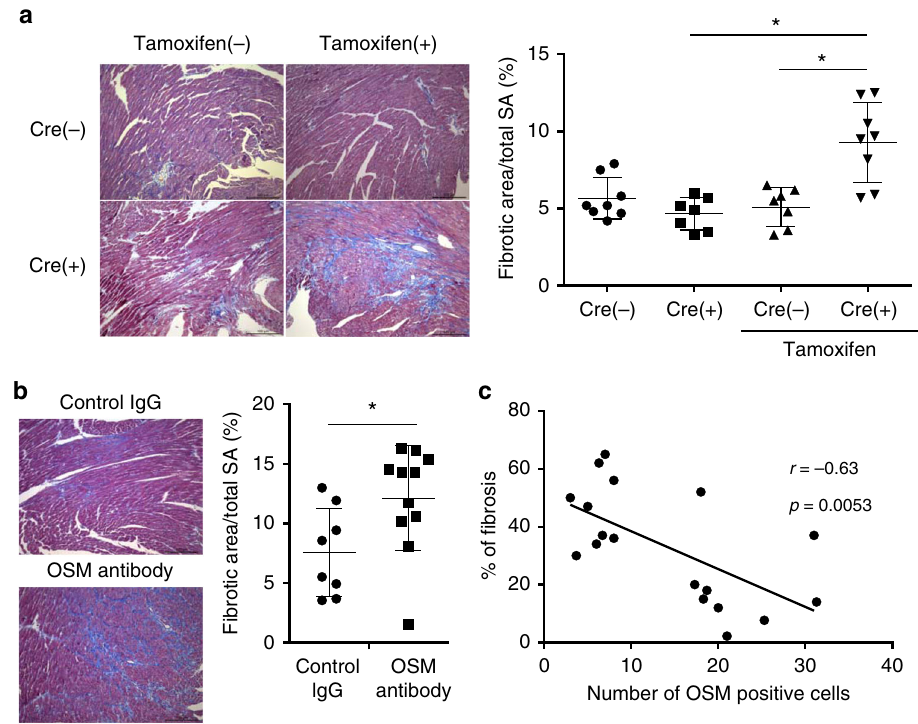
Fig. 6 OSM suppresses cardiac fi brosis in vivo. Masson ’ s trichrome staining was performed using cardiac tissue of fi broblast-speci fi c Osmr knockout mice ( OSMR fl ox/ fl ox ; Col1a1-creERT , Cre( + )) 14 days after TAC operation. Cre negative littermates (Cre( − )) or tamoxifen untreated littermates were used as controls. Fibrotic area was calculated compared to the total surface area (SA) (right). The Kruskal – Wallis test was used for the statistical analysis. (Cre( − ), tamoxifen( − ): n = 8, Cre( + ), tamoxifen( − ): n = 7, Cre( − ), tamoxifen( + ): n = 7, Cre( + ), tamoxifen( + ): n = 8). Scale bar = 100 μ m. b The effect of neutralizing antibody to OSM on cardiac fi brosis was examined. Neutralizing antibody to OSM (100 μ g) or control IgG (100 μ g) was injected intravenously 3 days after TAC operation. Masson ’ s trichrome staining was performed using cardiac tissue 14 days after TAC operation. Fibrotic area was calculated compared to the total surface area (SA). The Mann – Whitney U test was used to compare differences between the control IgG ( n = 8) group and OSM antibody group ( n = 11). Data show the mean and the standard deviation (error bar). Scale bar = 100 μ m. c The correlation between the area of cardiac fi brosis and the number of OSM-positive cells was examined. Linear regression analysis was used for the correlation between percent of fi brotic area and the number of OSM-positive cells in the heart specimens from human heart failure patients ( n = 18). * p < Cells, reagents, recombinant proteins, and antibodies . Mesenchymal stem cell line C3H10T1/2 cells were purchased from American Type Culture Collection. C3H10T1/2 cells were grown in DMEM (Dulbecco ’ s Modi fi ed Eagle Medium) medium containing 10% fetal bovine serum (HyClone, GE Healthcare Japan, Tokyo, Japan) in a 37°C incubator (5% CO 2 ). TEPMs were collected from the peritoneal cavity 4 days after the intraperitoneal injection of 3% thioglycollate solution (Fluka, Sigma – Aldrich, St Louis, MO, USA) using female mice. TEPMs were grown in RPMI1640 (GIBCO, Life technologies, Carlsbad, CA, USA) medium